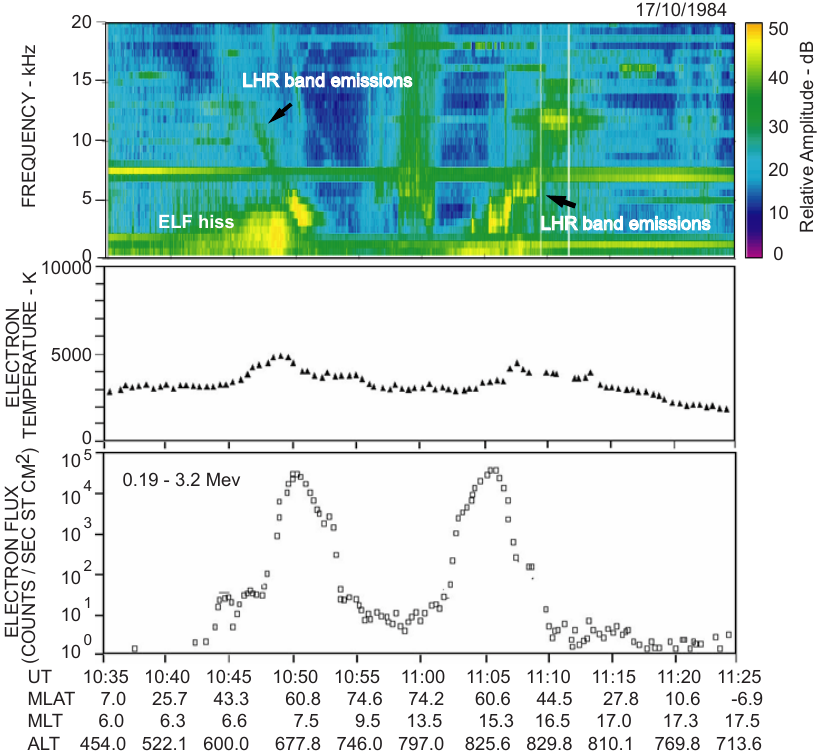
Fig. 8. Relationship among the LHR band emissions, the ionospheric electron temperature, and the energetic particle phenomena on 17 October 1984. Top panel: Dynamic spectrum of the VLF waves. LHR band emissions were detected in the middle latitude between about 43 ◦ and 60 ◦ . Second panel: electron temperature. Third panel: relativistic electron flux (0.19 to